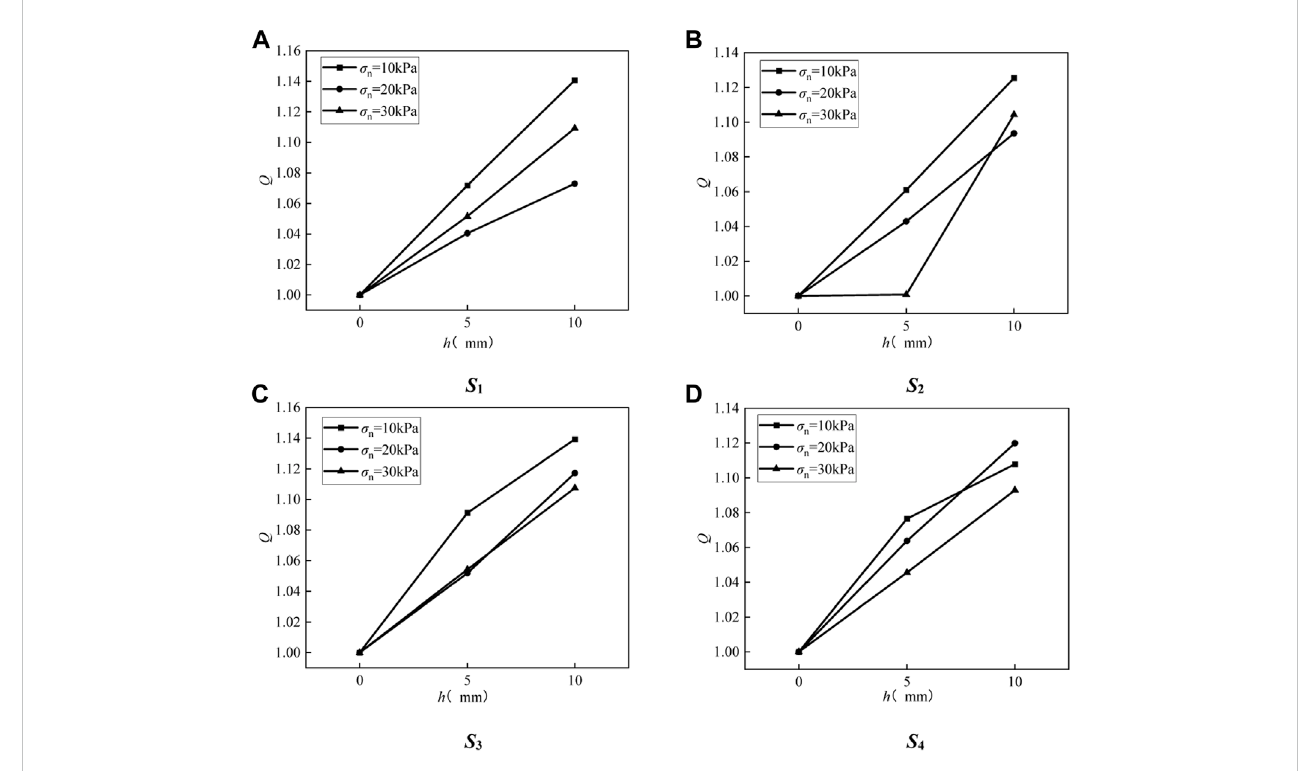
FIGURE 5 Q~h curve of the warp-knitted toothed